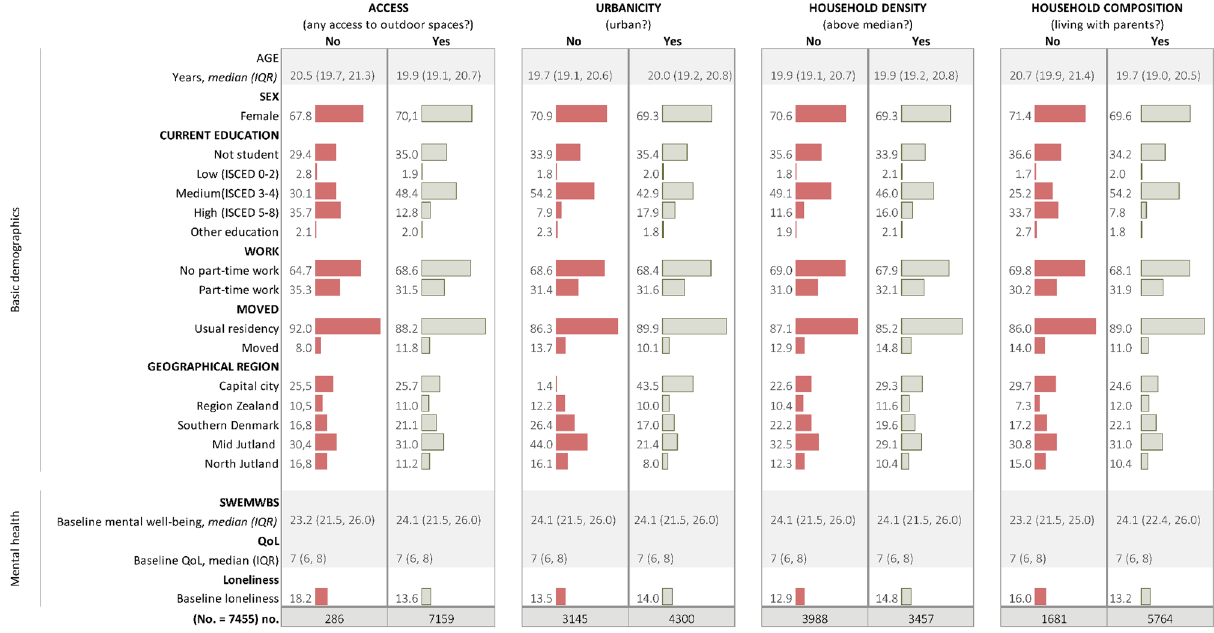
Figure 1. Demographic characteristics by housing conditions (No. = 7445). IQR Interquartile range, ISCED International Standard Classification of Education, SWEMWBS Short Warwick-Edinburgh Mental Well-Being Scale, QoL Quality of Life. Relative frequencies presented, unless otherwise stated.